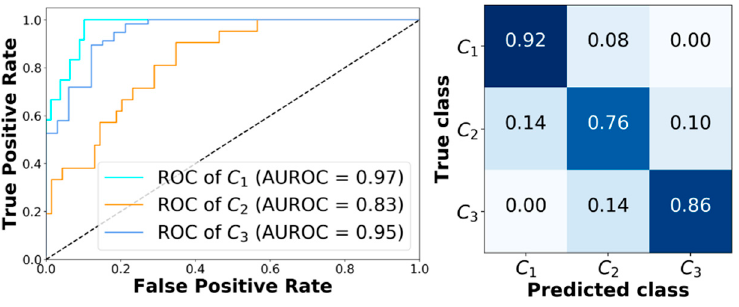
Figure 4. Classification results obtained with XGB corresponding to adult#1. Left panel: Receiving operator characteristic (ROC) curves obtained with XGB for C 1 , C 2 , and C 3 . Right panel: The corresponding confusion matrix.